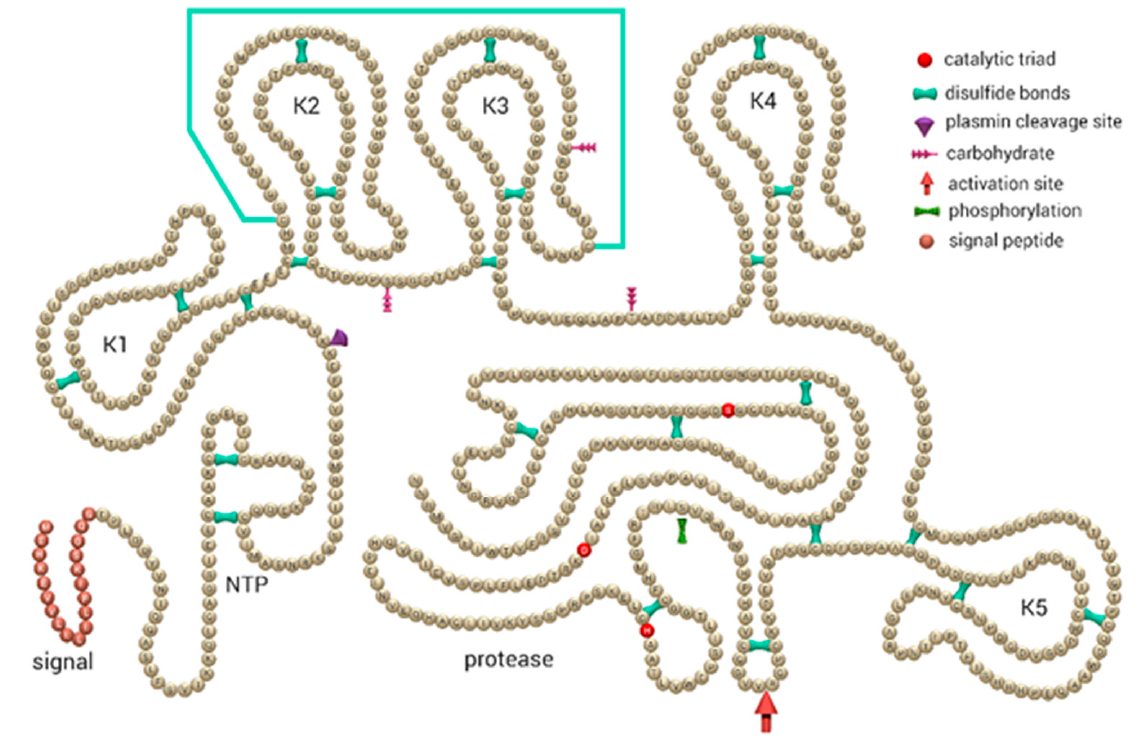
Figure 1. Schematic representation of the primary structure of human glutamic (Glu)-plasminogen. The catalytic triad (His603, Asp646, and Ser741) within the protease domain, the activation site (Arg561–Val562), and the 24 disulfide bridges as well as the signal peptide are indicated. NTP, N-terminal peptide; K1–K5, kringles 1–5. Previously published [3] and adapted from Schaller and Gerber [4].